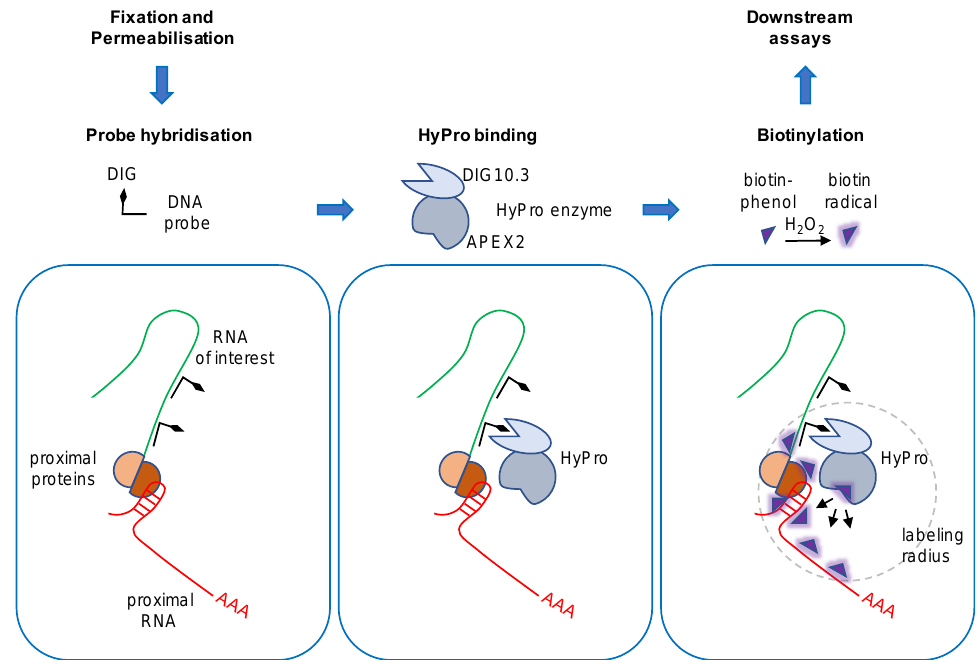
Figure 2. The HyPro labeling workflow. HyPro labeling is performed in mammalian cells of interest. For probe hybridisation, a panel of digoxigenin (DIG)-labeled DNA oligonucleotides (black) that are complementary to the RNA of interest (green) are added to fixed and permeabilised cells. Next, the purified HyPro enzyme is added. The recombinant fusion protein consists of the engineered digoxigenin-binding protein DIG10.3 and the engineered ascorbate peroxidase 2 (APEX2). High affinity binding of DIG10.3 to DIG tethers HyPro to the RNA of interest. For the biotinylation of proximal proteins and transcripts (red), biotin-phenol (purple) is added and converted to reactive biotin-radicals (purple glow) in the presence of hydrogen peroxide (H 2 O 2 ) for a few minutes. Proximity ligation occurs within a labeling radius of 20 nm (grey). Subsequently, cells are lysed, biotinylated molecules are purified and subjected to downstream assays such as mass spectrometry and deep sequencing. Schematic illustrations were adopted from Yap and colleagues [17,82].